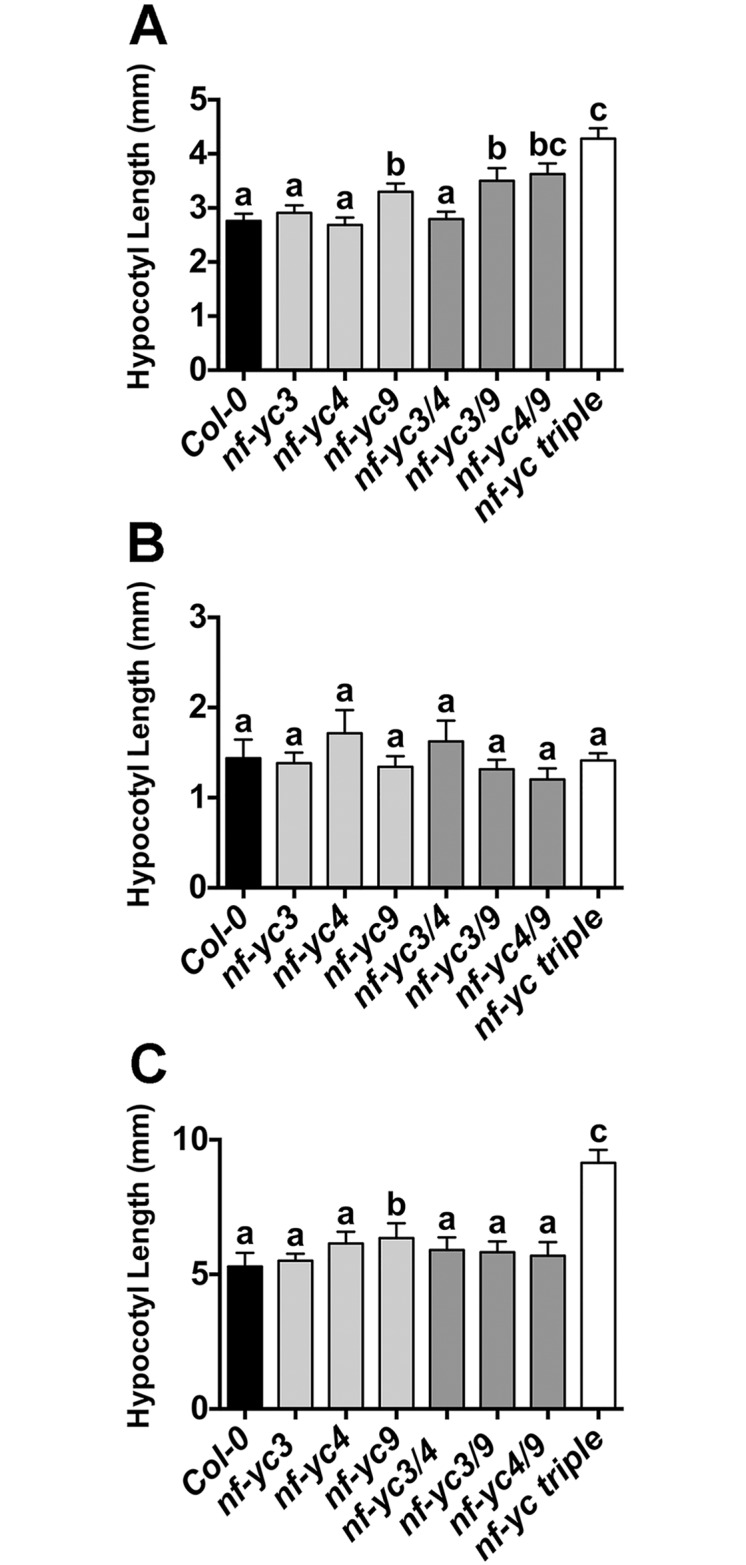
NF-YC3, 4, and 9 are necessary for suppression of hypocotyl elongation in both cB and cR light.Hypocotyl lengths are shown for five day old plants grown on B5 media in A) cB (38μmol m-2 s-1), B) cFR (5μmol m-2 s-1), and C) cR (6μmol m-2 s-1). Statistically significant differences between groups (or lack thereof) are represented by lettering above bars (error bars represent 95% confidence intervals). Statistical differences were determined by standard ANOVA (p<0.01) when variances were not significantly different (cFR and cR) and Kruskal-Wallis ANOVA (non-parametric test, p<0.05) when variances were unequal (cB). Subsequent multiple comparisons were performed by either Tukey’s (cFR, cR) or Dunn’s (cB) procedures, respectively.